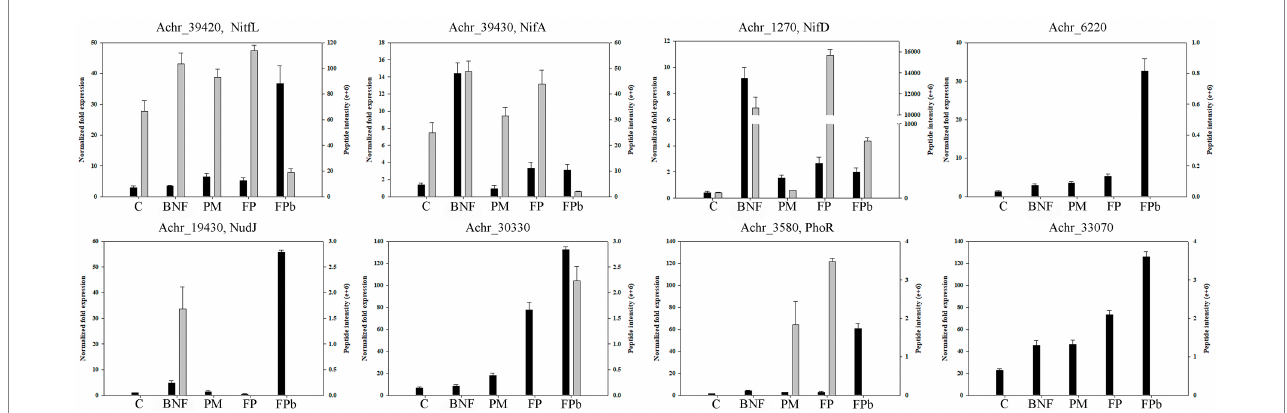
FIGURE 7 Transcriptional analysis of some genes coding for relevant proteins related to biological nitrogen fixation and phosphorus mobilization, and comparison with the peptide intensities obtained by proteomics. RNA levels (black bars) and peptide intensity (gray bars) are shown. Achr_39420 (A0A0C4WKJ2), NifL; Achr_39430 (A0A0C4WRR3), NifA; Achr_1270 (A0A0C4WIV2), NifD; Achr_6220 (A0A0C4WJR7), alkaline phosphatase; Achr_19430 (A0A0C4WHX1) phosphatase NudJ; Achr_30330 (A0A0C4WPA5), alkaline phosphatase; Achr_3580 (A0A0C4WJ43), phosphate regulon sensor kinase PhoR; Achr_33070 (A0A0C4WQ17) acid phosphatase/vanadium-dependent haloperoxidase superfamily. C, control condition; BNF, biological nitrogen fixation condition; PM, phosphorus mobilization condition; FP, biological nitrogen condition and phosphorous condition (21 h); FPb, biological nitrogen condition and phosphorous condition (72